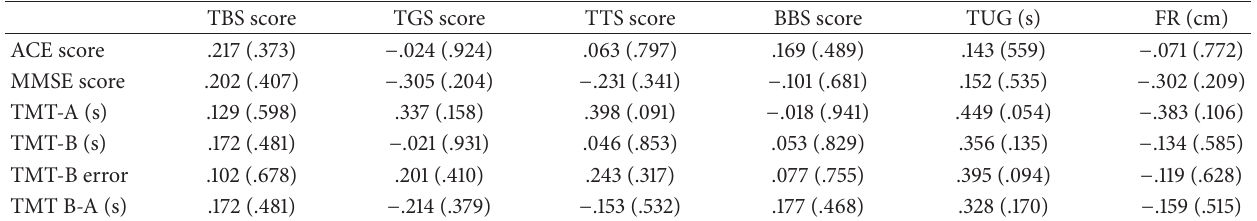
Table 6: Correlations between cognitive function and the gait and balance measures for the control